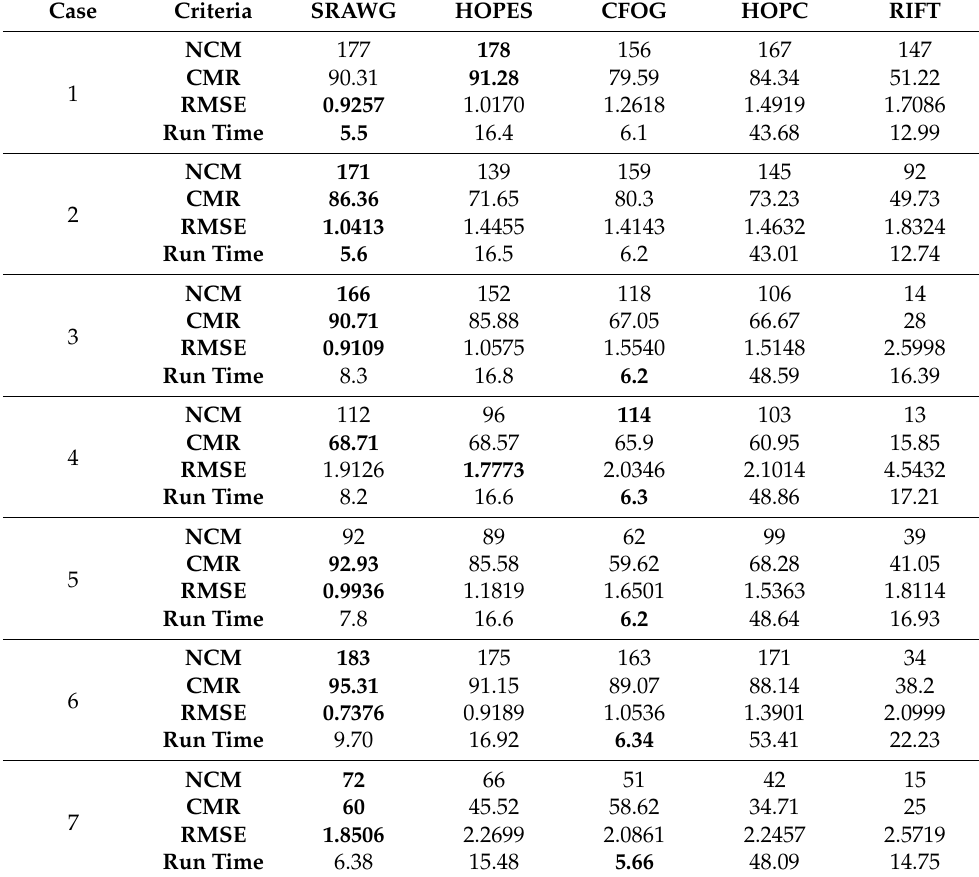
Table 3. NCM, CMR, RMSE, and run time of four methods. For each pair of experimental images, four metrics are used to measure the algorithm being compared. The numbers labeled in bold represent the optimal values for all algorithms under this